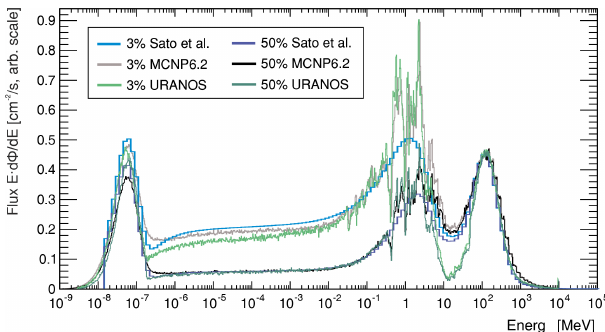
Figure 15. Cosmic-ray neutron spectrum comparison for 3% (light colors) and 50% (dark colors) soil moisture. The spectrum, which is generated from the analytical functions from Sato (2016), is shown in blue. The black hole mode spectra from Sato (2016), see also Fig. 5, are used as input distributions at a height of 500m and re- leased onto the soil. The resulting intensity distribution is shown for MCNP (black) and URANOS (green) in